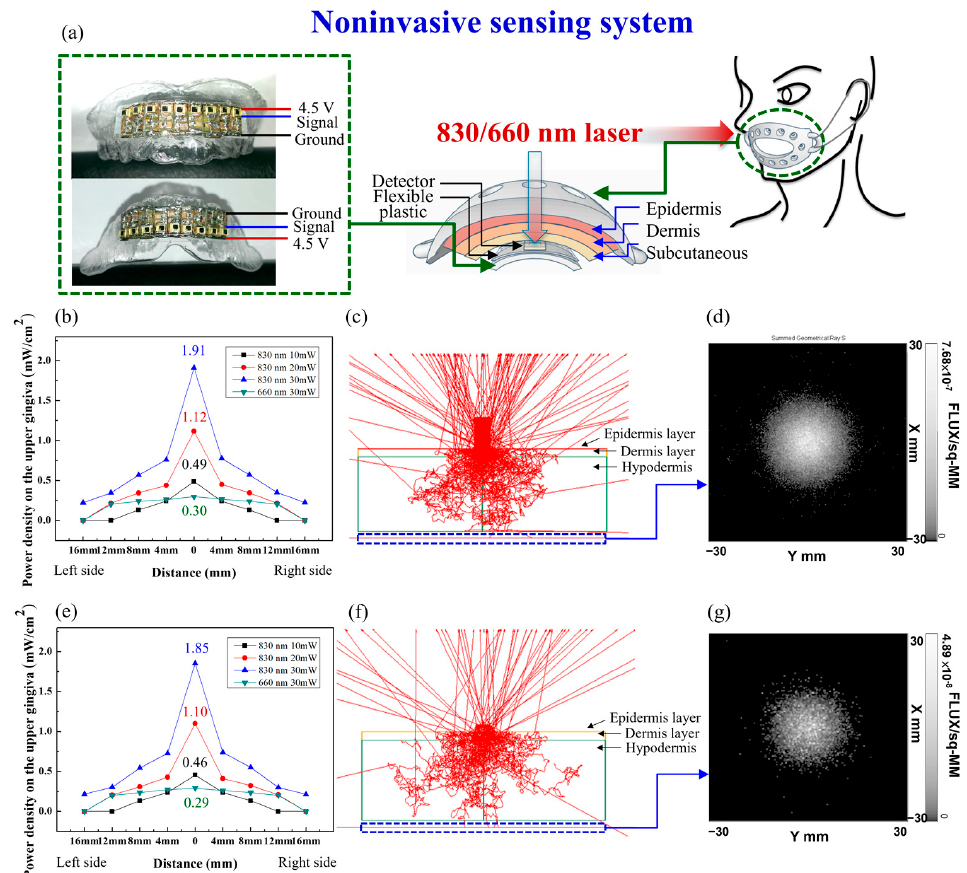
Figure 2. ( a ) Power densities of 830/660 nm lasers measured on the attached gingiva by a non-invasive sensing system. ( b ) Power densities analysis for a collimated laser on the upper attached gingiva for a male [27]. ( c ) The simulation of light scattering in a two-dimensional skin model and ( d ) the photon pattern after 825 nm laser penetrated skin for collimated laser. ( e ) Power density analysis for a laser without a lens on the upper attached gingiva for a male [27]. ( f ) The simulation of light scattering in a two-dimensional skin model and ( g ) the photon pattern after a 825 nm laser penetrated in skin for an uncollimated laser.